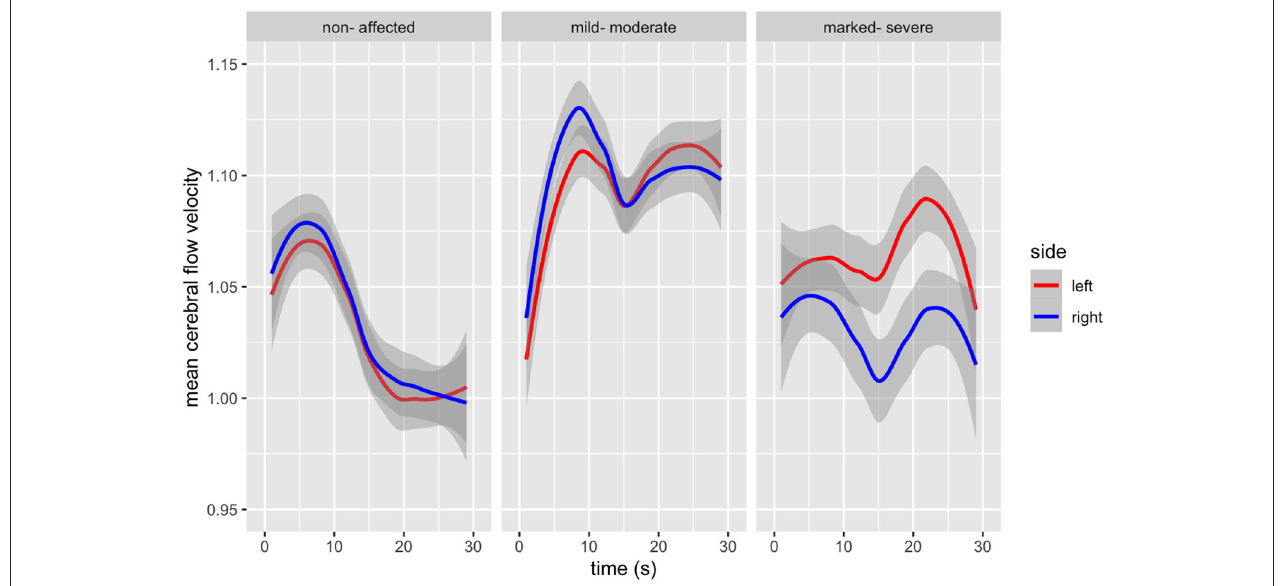
FIGURE 2 | Bilateral Mean Flow Velocity changes from baseline in the Middle Cerebral Artery during the duration of the TMT-B (in seconds), according to psychopathological symptom load [ F (6, 2,692) = 61.93, p <